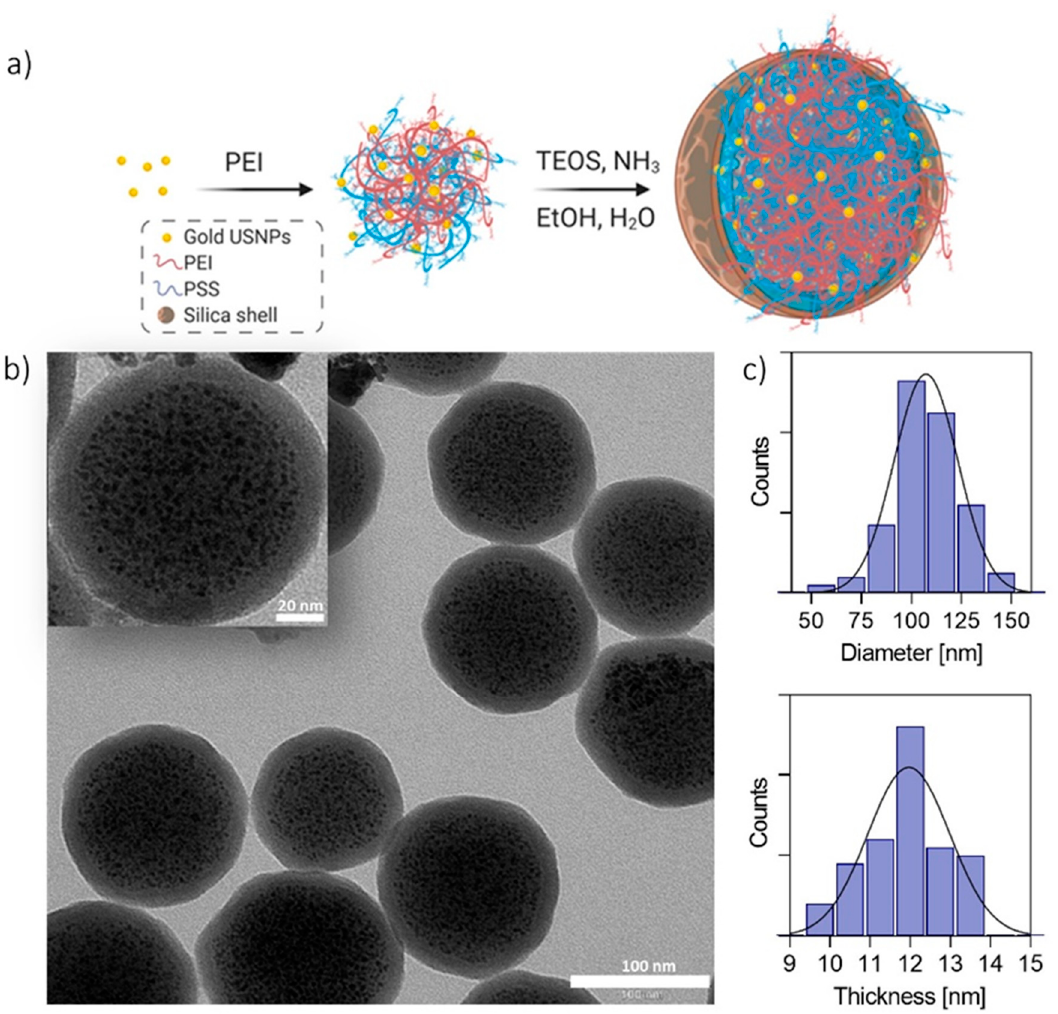
Figure 1. ( a ) Scheme for the synthesis of dragon fruit nano-architectures (dNAs). Gold seeds are synthesized in the presence of poly(sodium 4-styrenesulfonate) (PSS) and assembled in controlled aggregates with polyethyleneimine (PEI). The aggregates are employed as templates for the formation of silica nanocapsules. ( b ) Typical transmission electron microscopy (TEM) image of dNAs. Scale bar: 100 nm. Inset: zoom on one dNA. Scale bar: 20 nm. ( c ) Size diameter distribution and silica shell thickness histograms of dNAs, performed on 150 nanoparticles .